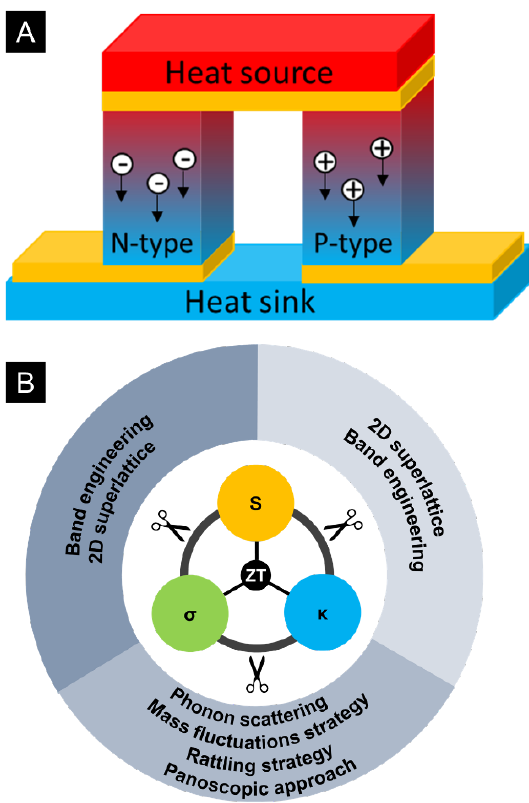
Figure 1. ( A ) Schematic of Seebeck effect; ( B ) schematic of interdependent relationship of Seebeck coefficient, electrical conductivity, and thermal conductivity, and the strategies to decouple their interdependency.